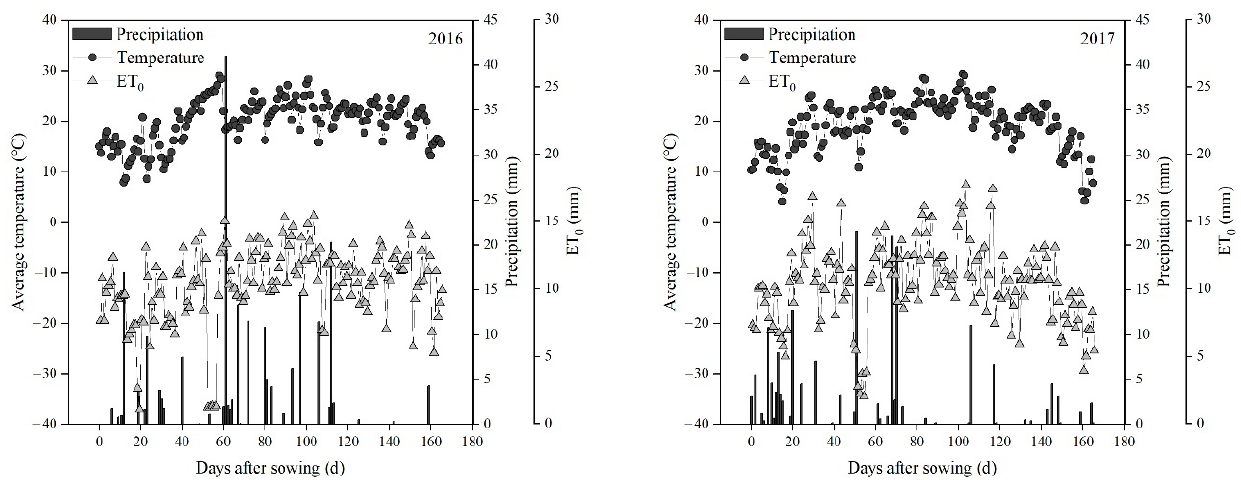
Figure 1. Precipitation, average air temperature, and reference evapotranspiration during the maize growing season.